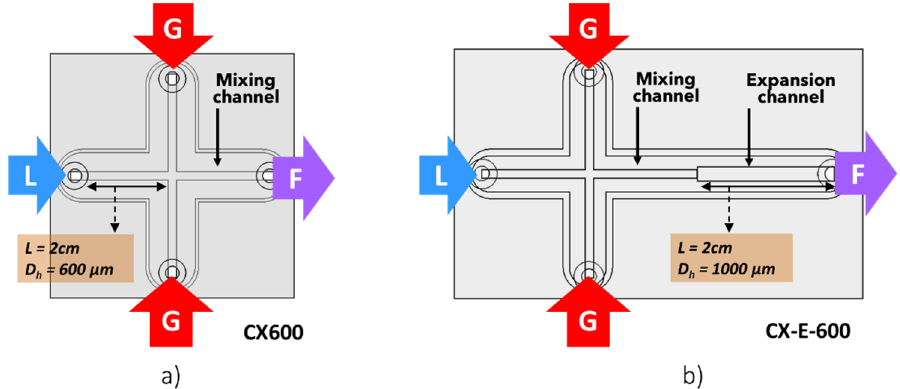
Figure 2. Schematic representation of the microfluidic devices. ( a ) reference device (CX600). ( b ) device with the same cross-shaped configuration, but with an integrated expansion channel downstream from the mixing channel (CX-E-600). Liquid solution (L), N 2 (G), and gas–liquid dispersions which turn into foam along the processing line (F).